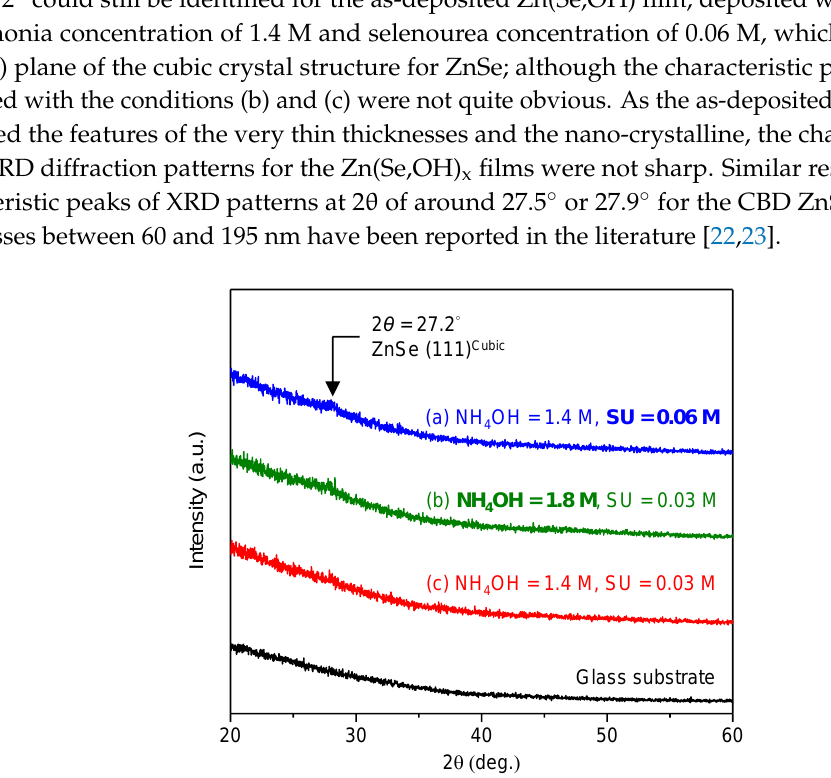
Figure 5. Thicknesses and deposition rates of Zn(Se,OH) films deposited with various ammonia concentrations and selenourea concentrations.